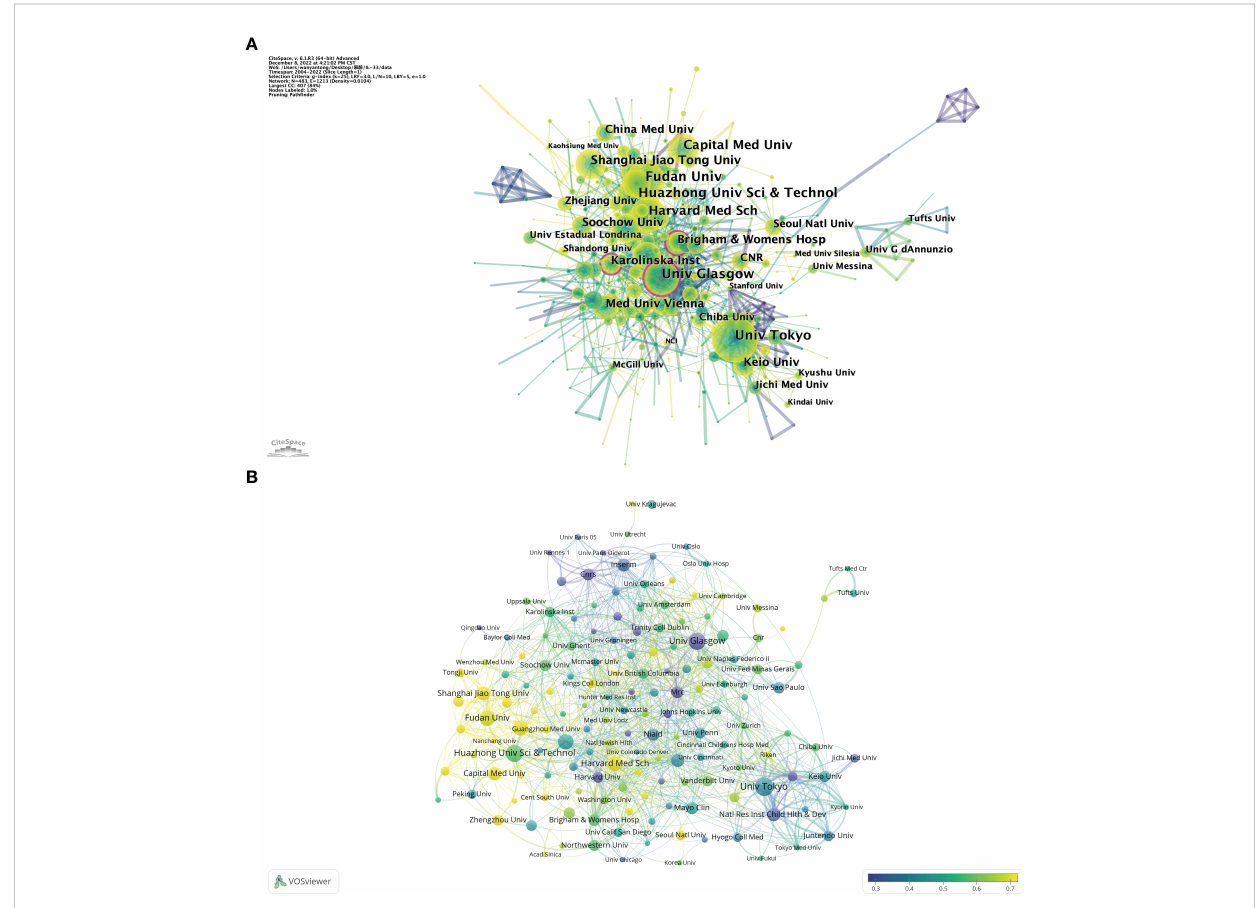
FIGURE 3 The analysis of research institutions related to IL-33. (A) The co-occurrence map of research institutions. The node size means the co-occurrence frequencies, while the linkages mean the co-occurrence relationships. Nodes with purple round mean high betweenness centrality ( ≥ 0.1). (B) The proportion of institutional publications to complete publications during the last fi ve years. When the color bias is towards yellow, the ratio is larger; when the color bias is towards purple, the ratio is lower.